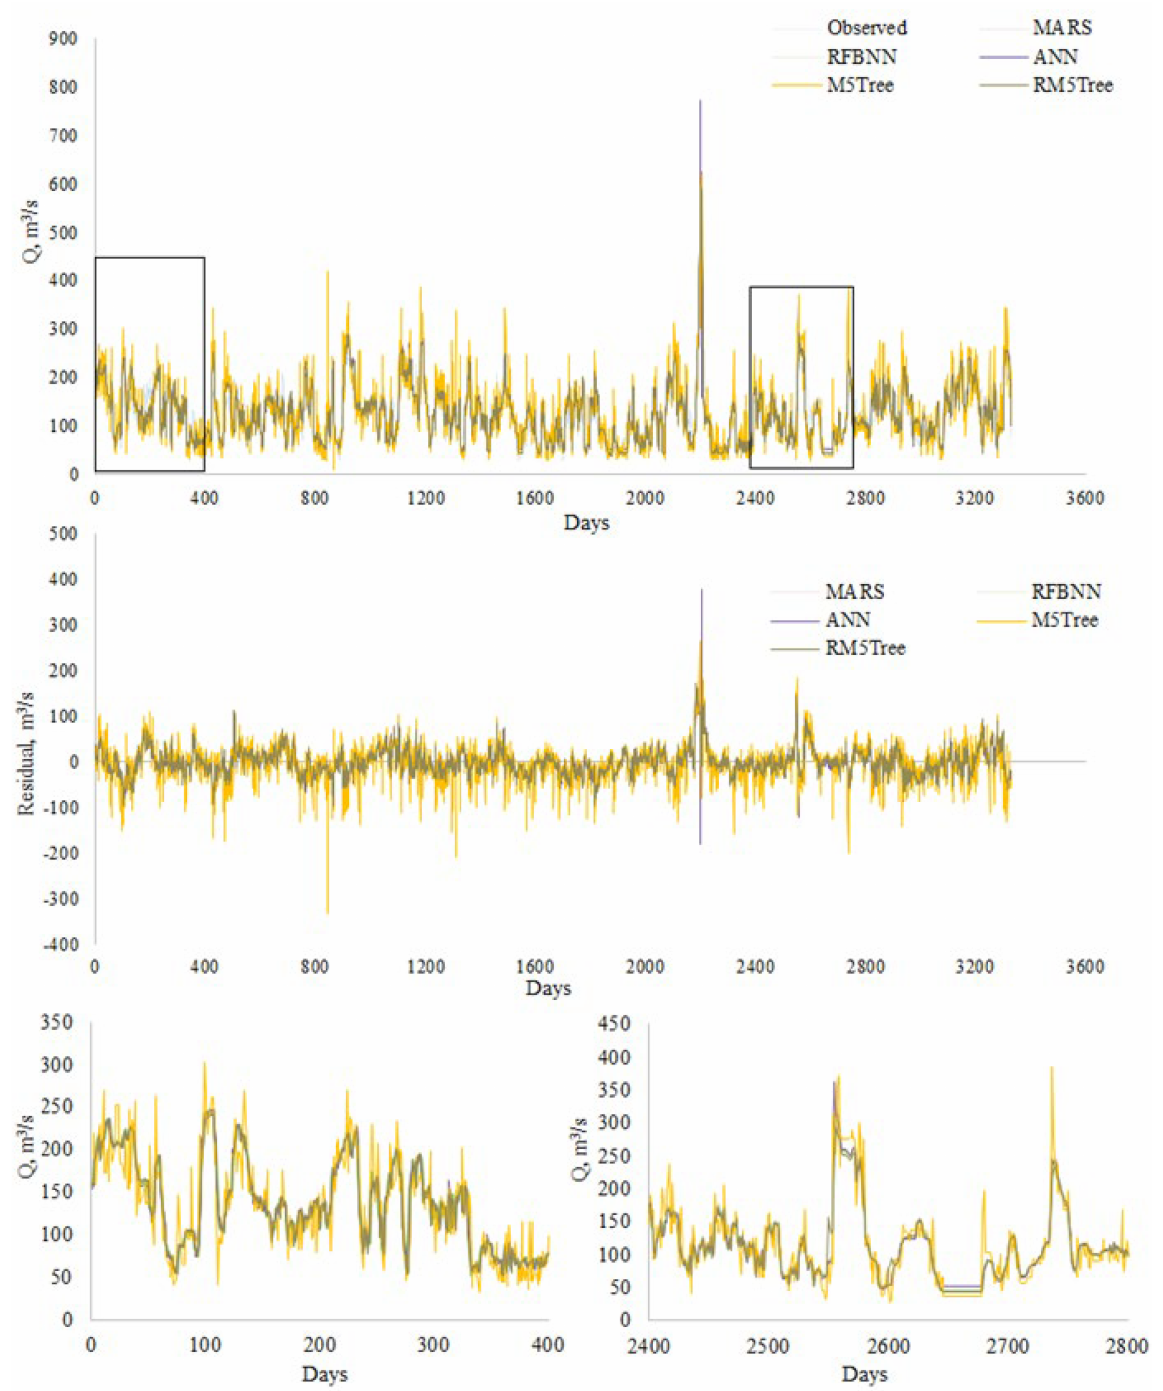
Figure 9. Time variation graphs of the observed and estimated streamflow of Skallbole Station (downstream) by RM5Tree, M5Tree, RBFNN, ANN, and MARS models in the test period using data of Ostavallselet Station